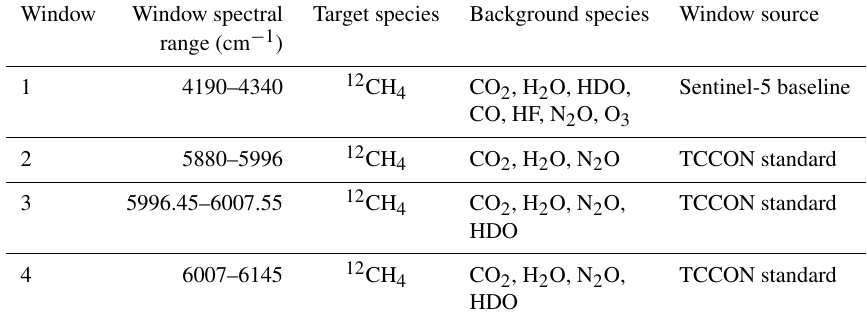
Table 3. Spectral windows used in